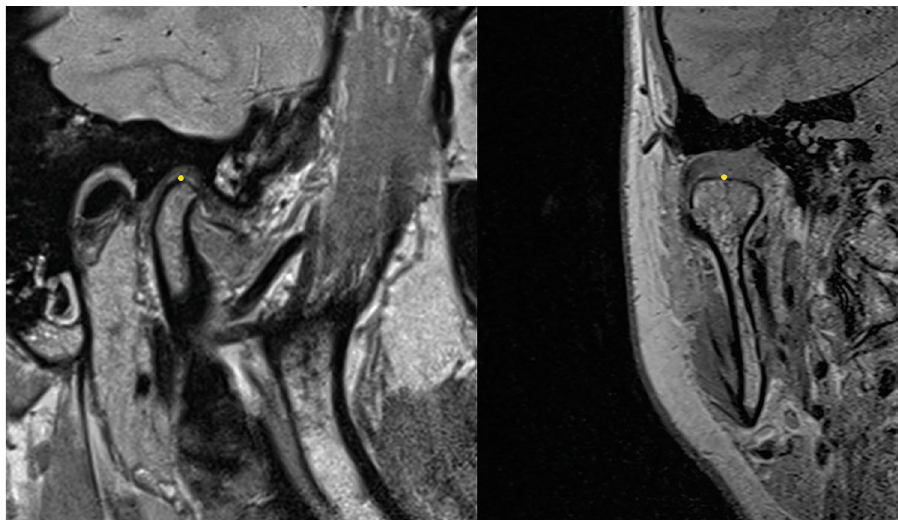
Figure 2. MRI scans in the parasagittal (left) and paracoronal views (right). Yellow dots indicate measuring points on central condyle